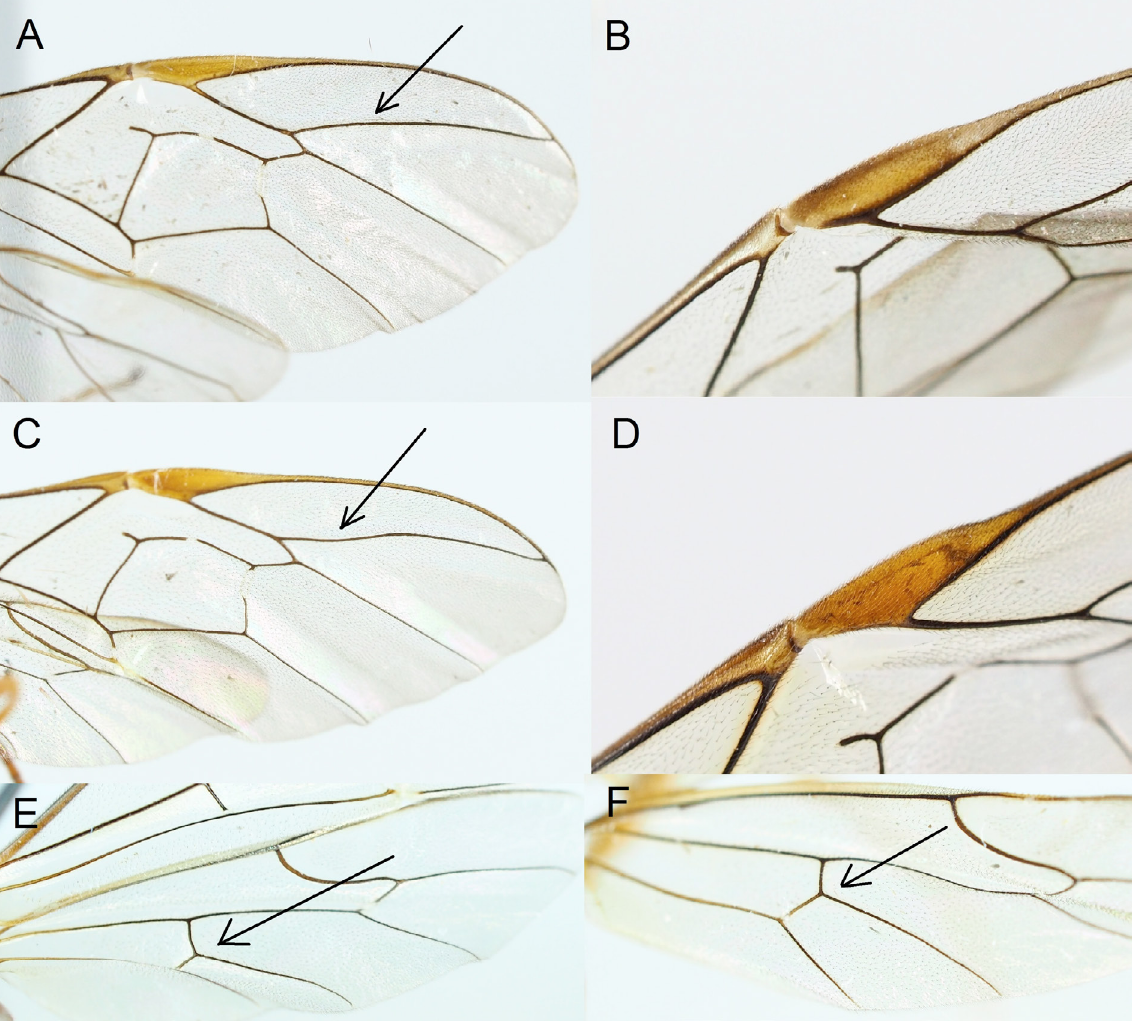
Fig. 13. A . right fore wing Ophion tenuicornis Johansson sp. nov., paratype, ♀ (NHRS-HEVA000008743), the evenly curved radius arrowed. B . Pterostigma O. autumnalis Johansson sp. nov., holotype, ♀ (NhrS-hEVA000008620). C . right fore wing O. inclinans Johansson sp. nov., holotype, ♀ (NHRS- hEVA000008667), the sinous radius arrowed. D . Pterostigma O. kevoensis Jussila, 1965. E–F . hind wing nervellus, interception of discoidella arrowed. E . O. brocki Johansson sp. nov., paratype, ♀ (NHRS- hEVA000008633). F . O. splendens Johansson sp. nov., paratype, ♀